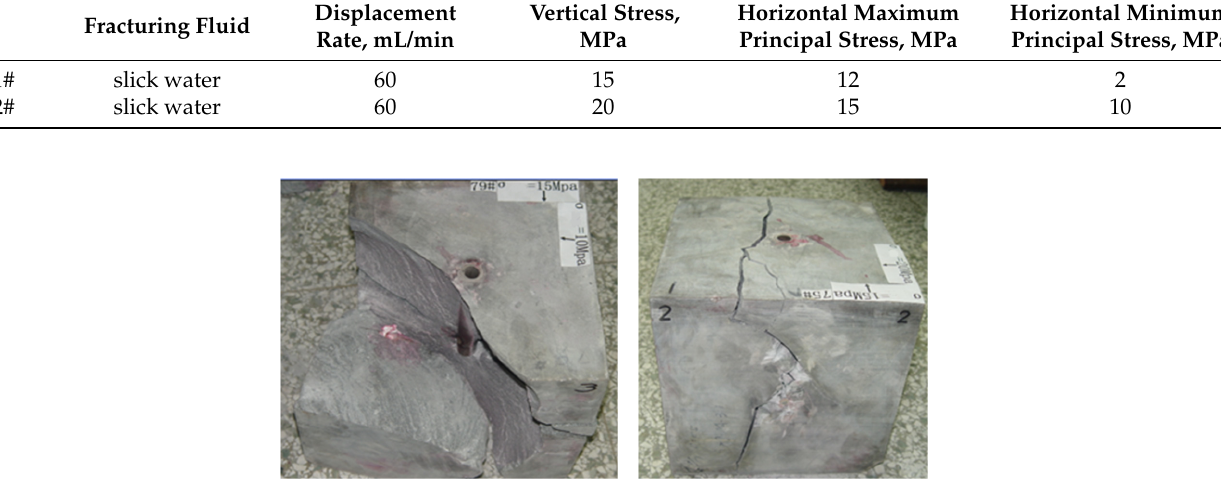
Figure 2. Fracturing results in different experimental parameters.